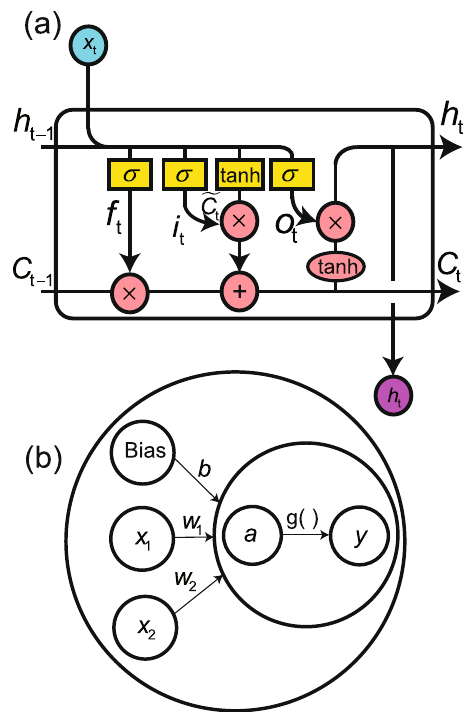
Fig. 6 Building blocks for LSTM layer and dense layer. The cells of a long – short-term memory (LSTM) layer and dense layer are presented in ( a ) and ( b ), respectively, where σ represents the sigmoid layer and tanh represents the tanh